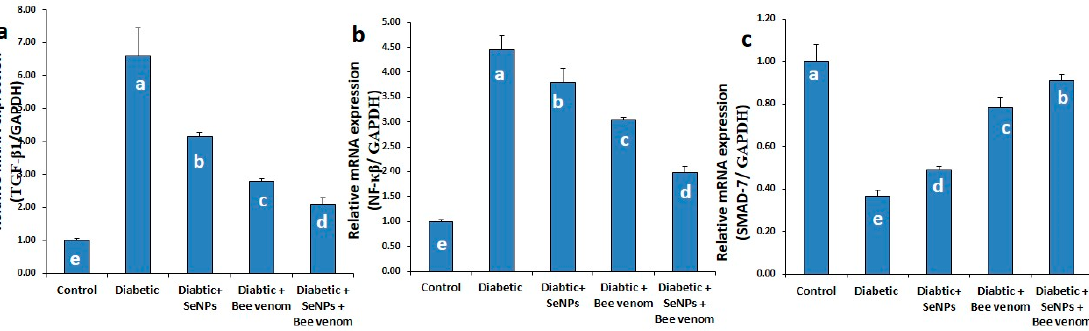
Figure 2. The expression levels of TGF- β 1 ( a ), NF- κβ ( b ) and SMAD-7 ( c ) genes in renal tissues of normal and STZ-diabetic rats.